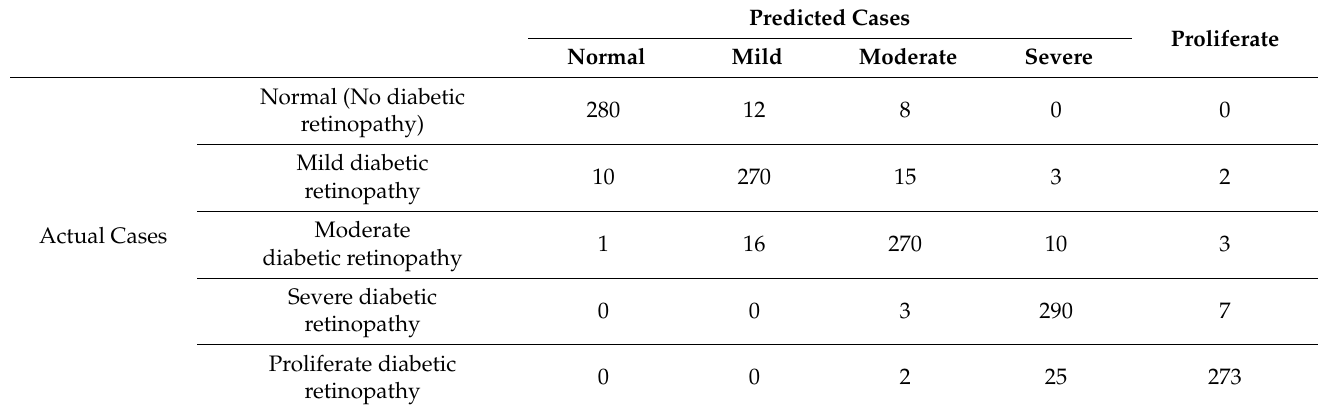
Table 7. Confusion matrix for the regression model (300 test cases for each class).